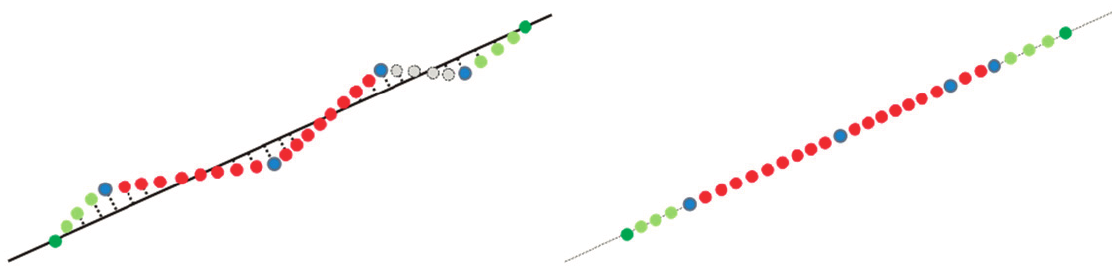
Blue dots circles represent the original ALS data, red dots: points added between original points, green dots: peripheral points and points between them. The described algorithm and procedures were implemented in the C#